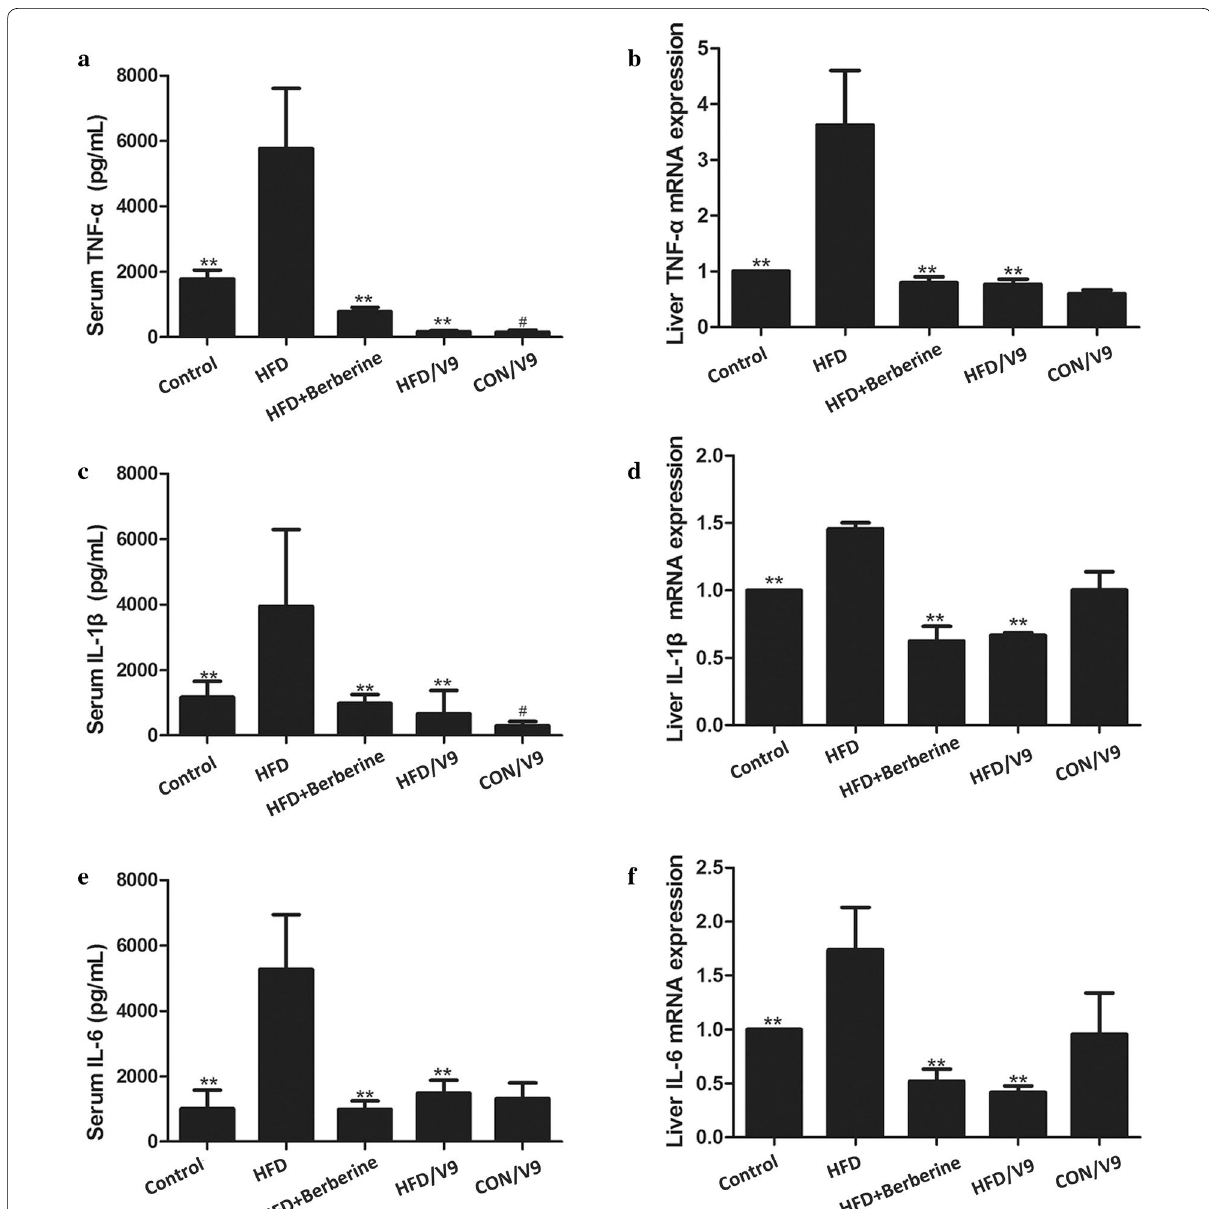
Fig. 4 V9 treatment reduces HFD-induced inflammatory responses. a Serum TNF-α production. b Hepatic TNF-α mRNA expression. c Serum IL-1β production. d Hepatic IL-1β mRNA expression. e Serum IL-6 production. f Hepatic IL-6 mRNA expression. Data are expressed as mean n 8, # P < 0.05 vs control group, and **P < 0.01 vs HFD =